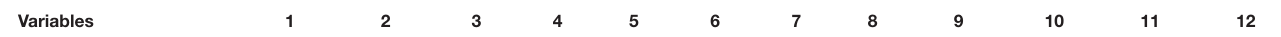
TABLE 2 | Pearson correlation coefficients for nature-related variables and indicators of occupational well-being. Variables NATURE-RELATED FACTORS